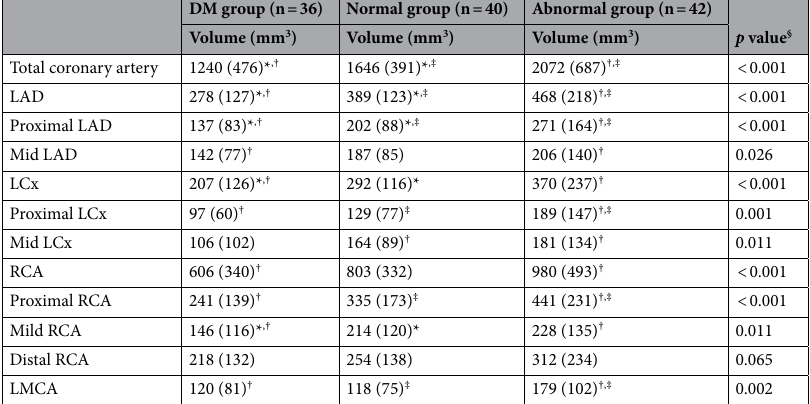
Table 1. Comparison of coronary volumes in groups. Data are expressed as mean (SD). LAD left anterior descending artery, LCx left circumflex artery, RCA right coronary artery, LMCA left main coronary artery. *Significant difference between DM and Normal. § ANOVA for DM group vs. Normal group vs. Abnormal group. † Significant difference between DM and abnormal. ‡ Significant difference between normal and abnormal.